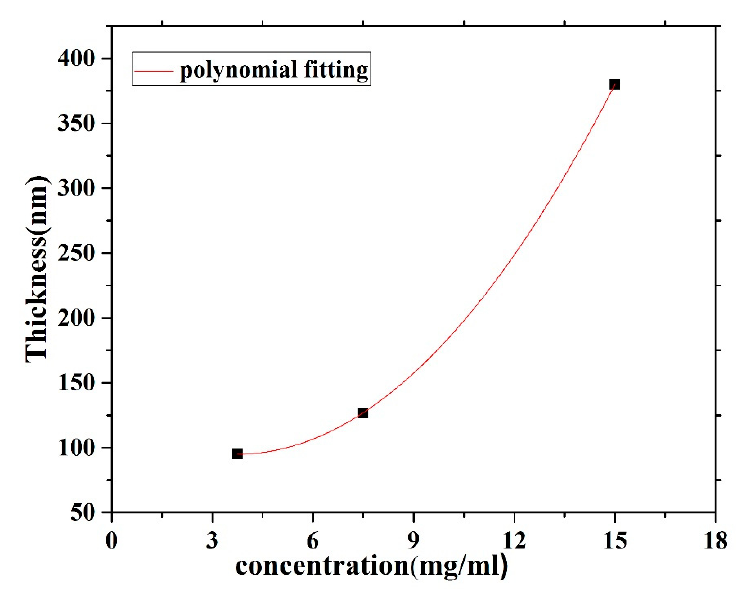
Figure 3. Film thickness versus the solution concentration for CO BEVC-DHF deposited by spin coating at 2000 rpm.